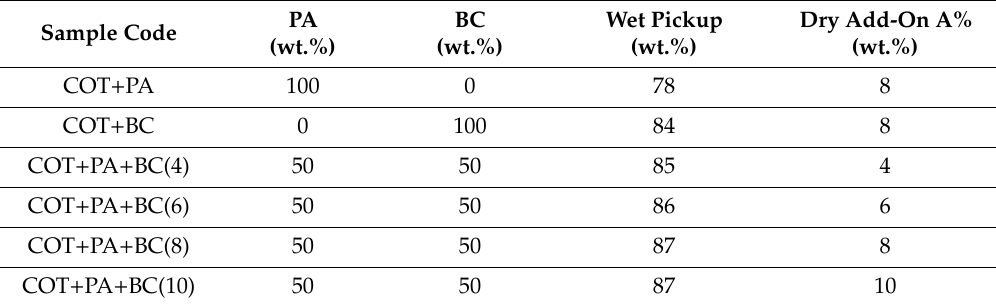
Table 1. Composition of the treated cotton fabrics